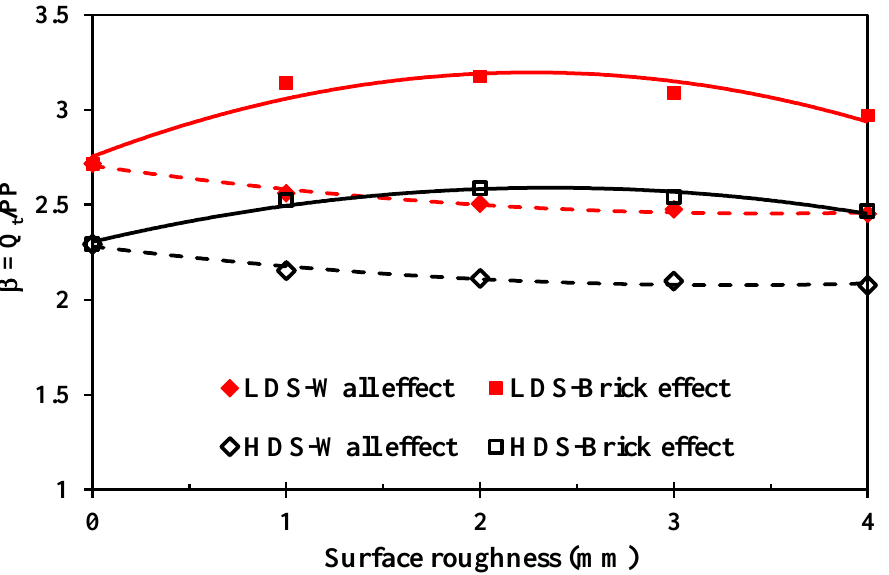
Figure 13. The effect of the wall and brick surface roughness on the ratio ( β ) of the heat transfer to pumping power.